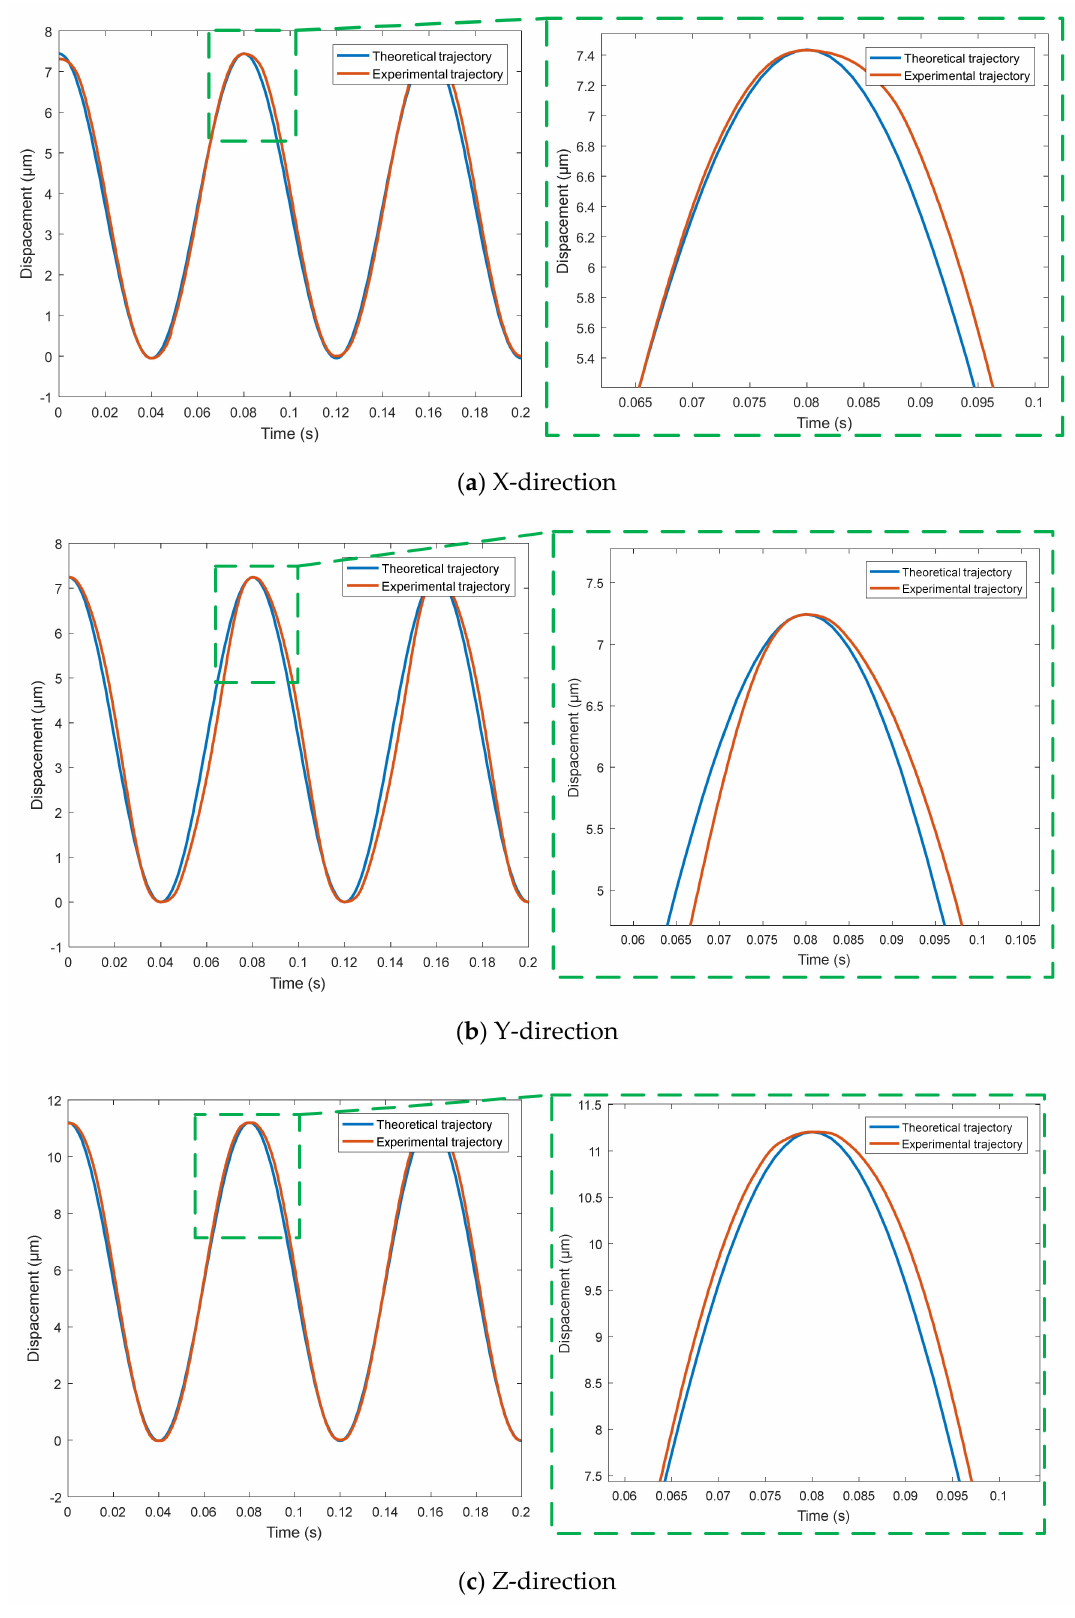
Figure 9. Trajectory tracking performance of sinusoidal response